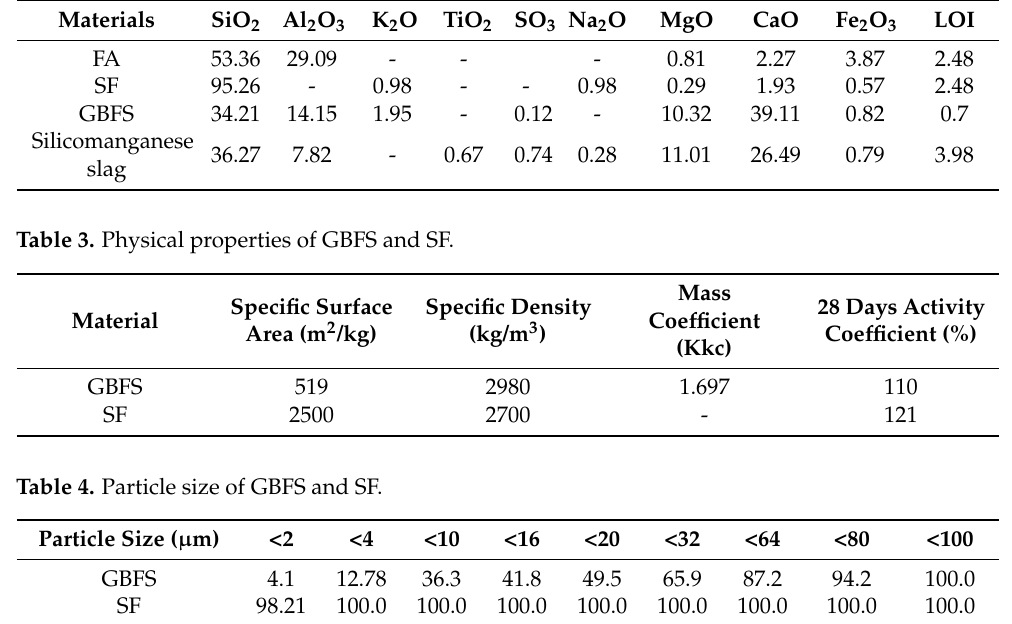
Table 2. Chemical composition of raw materials (%).